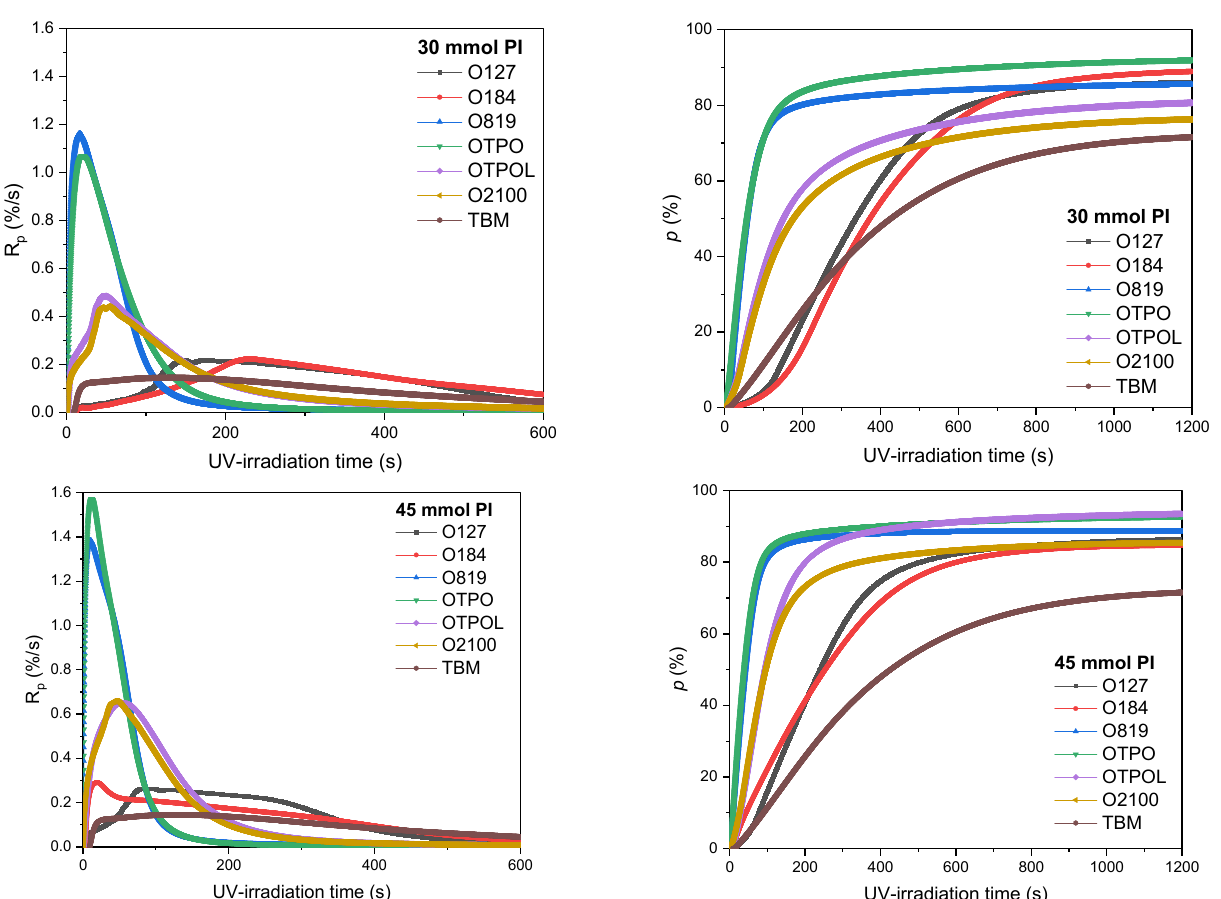
Figure 3. Kinetics parameters of BA, AA, and ABP photo-cotelomerization process in the presence of TBM as a chain transfer agent (I 0 = 15 mW/cm 2 ; 320–390 nm); R p - reaction rate; p- conversion of double bonds.